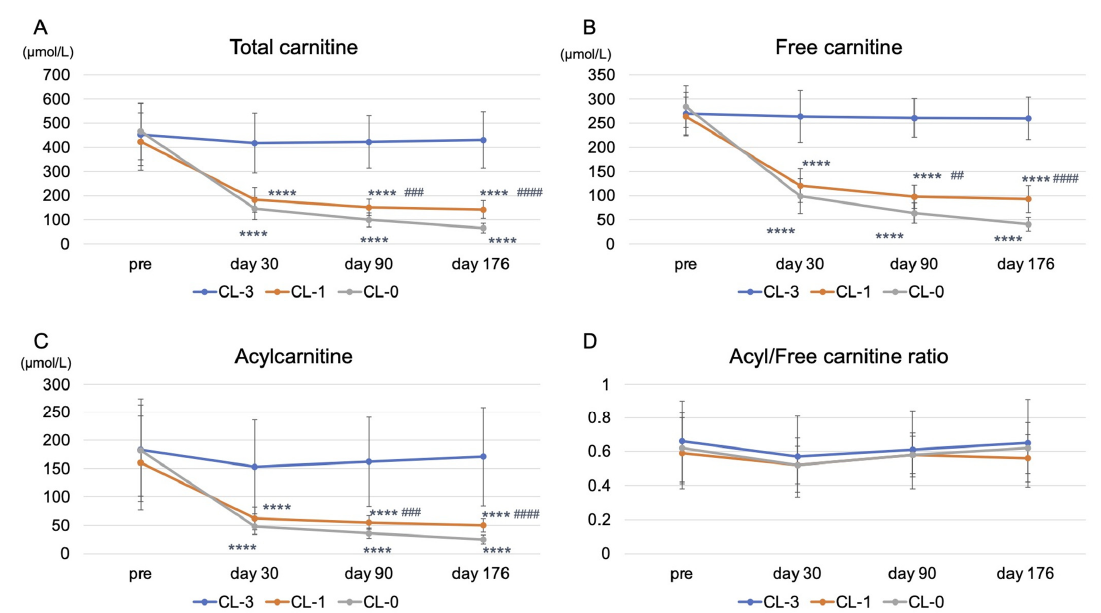
Figure 3. Kinetics of plasma total carnitine, free carnitine, acylcarnitine levels, and acyl/free carnitine ratio during the study. ( A ) plasma total carnitine levels; ( B ) plasma free carnitine levels; ( C ) plasma acylcarnitine levels; ( D ) acyl/free carnitine ratio. LC-3: LC 1000 mg three times weekly; LC-1: LC 1000 mg once and placebo (saline 5 mL) twice weekly; LC-0: placebo three times weekly (LC-0). **** p < 0.0001 vs. LC-3; ## p < 0.01; ### p < 0.001; #### p < 0.0001 vs. LC-0.